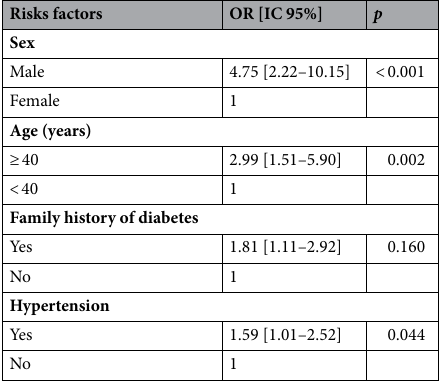
Table 4. Risk factors for diabetes in the population of Gombe